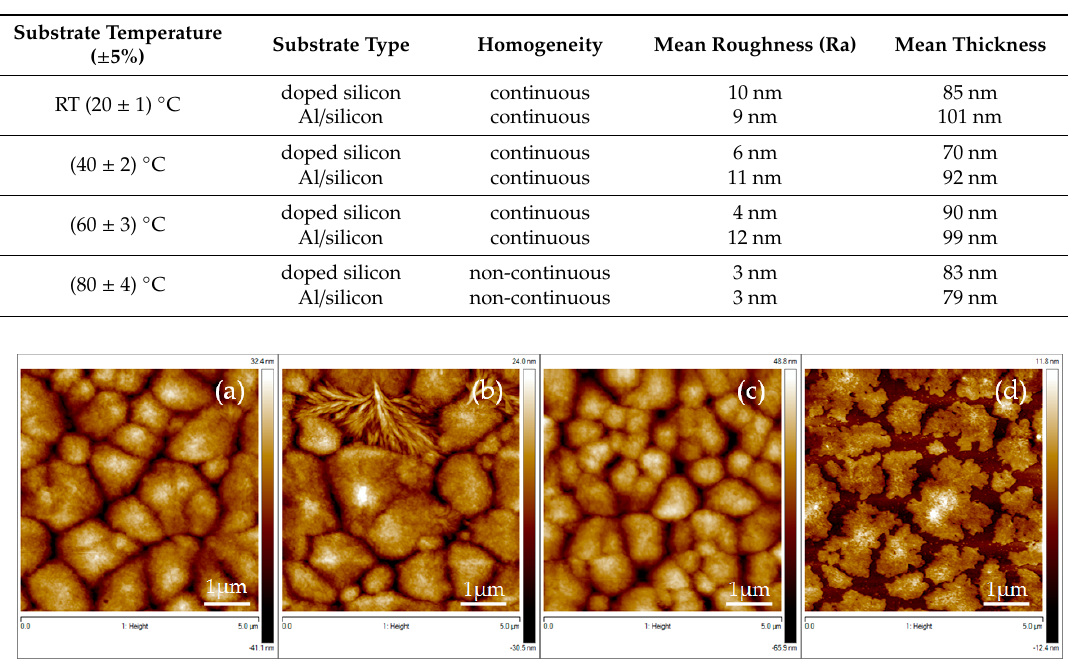
Table 2. Morphology characteristics of the PVDF thin films as function of the substrate temperature and the substrate type.